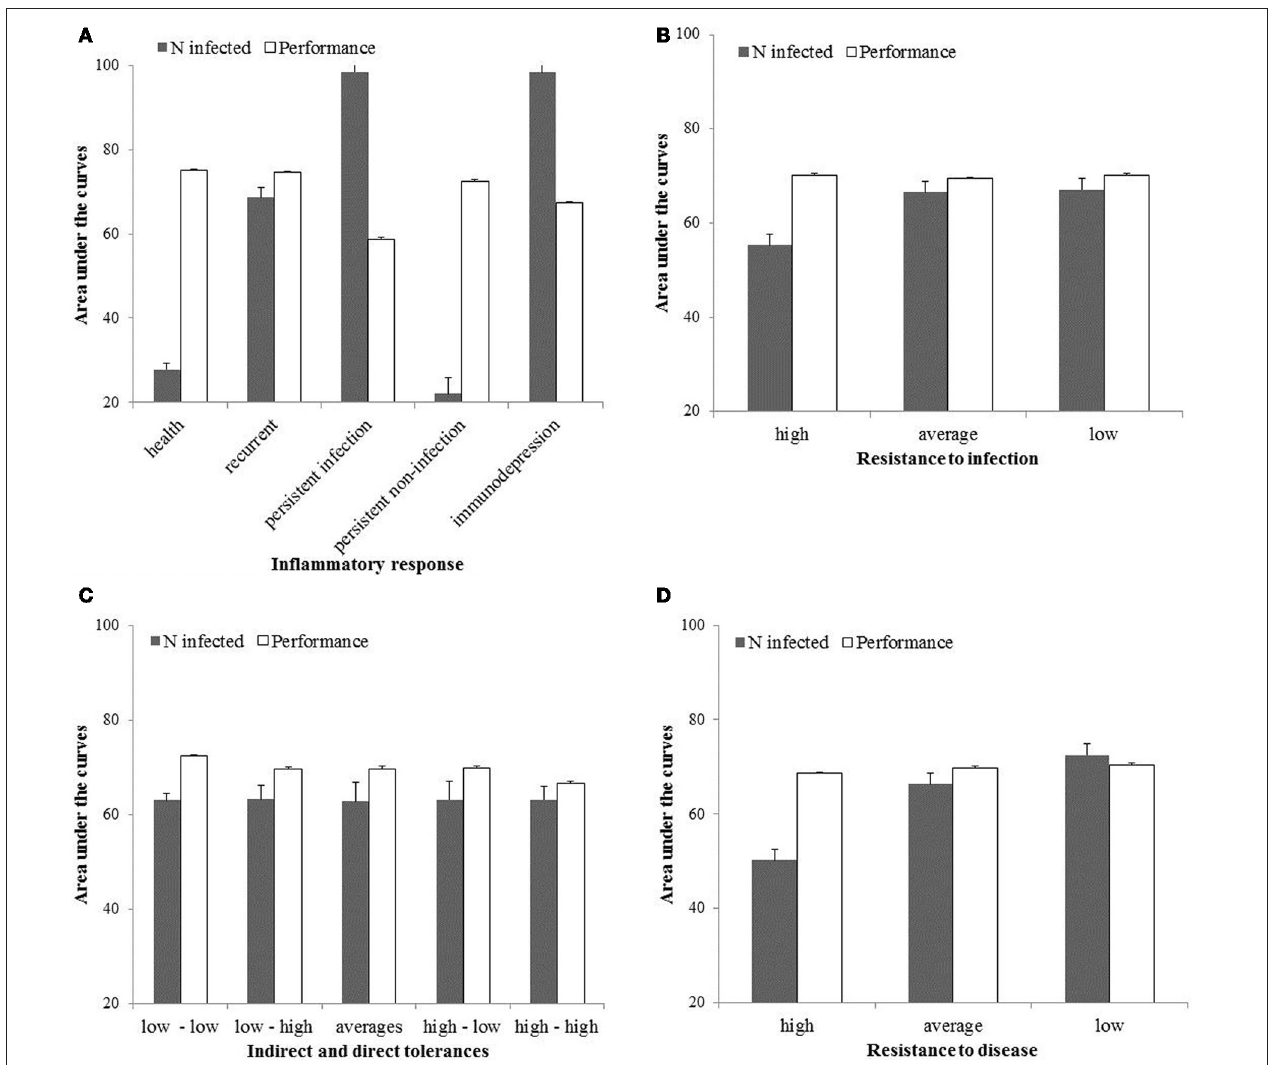
FIGURE 4 | Area under the curves for the host performances and number of infected in the population for the first 100 time-units and expressed as the percentages of their respective